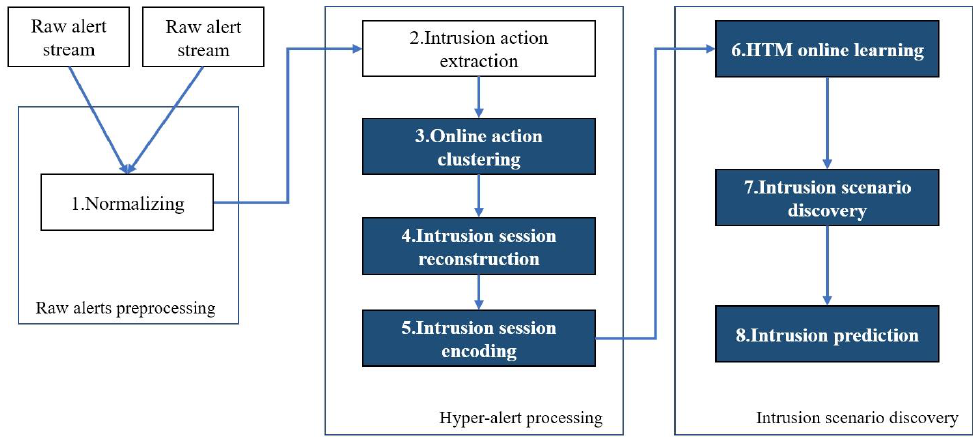
Figure 3. The components of the proposed framework. The rectangles in blue are the main contributions of this paper.